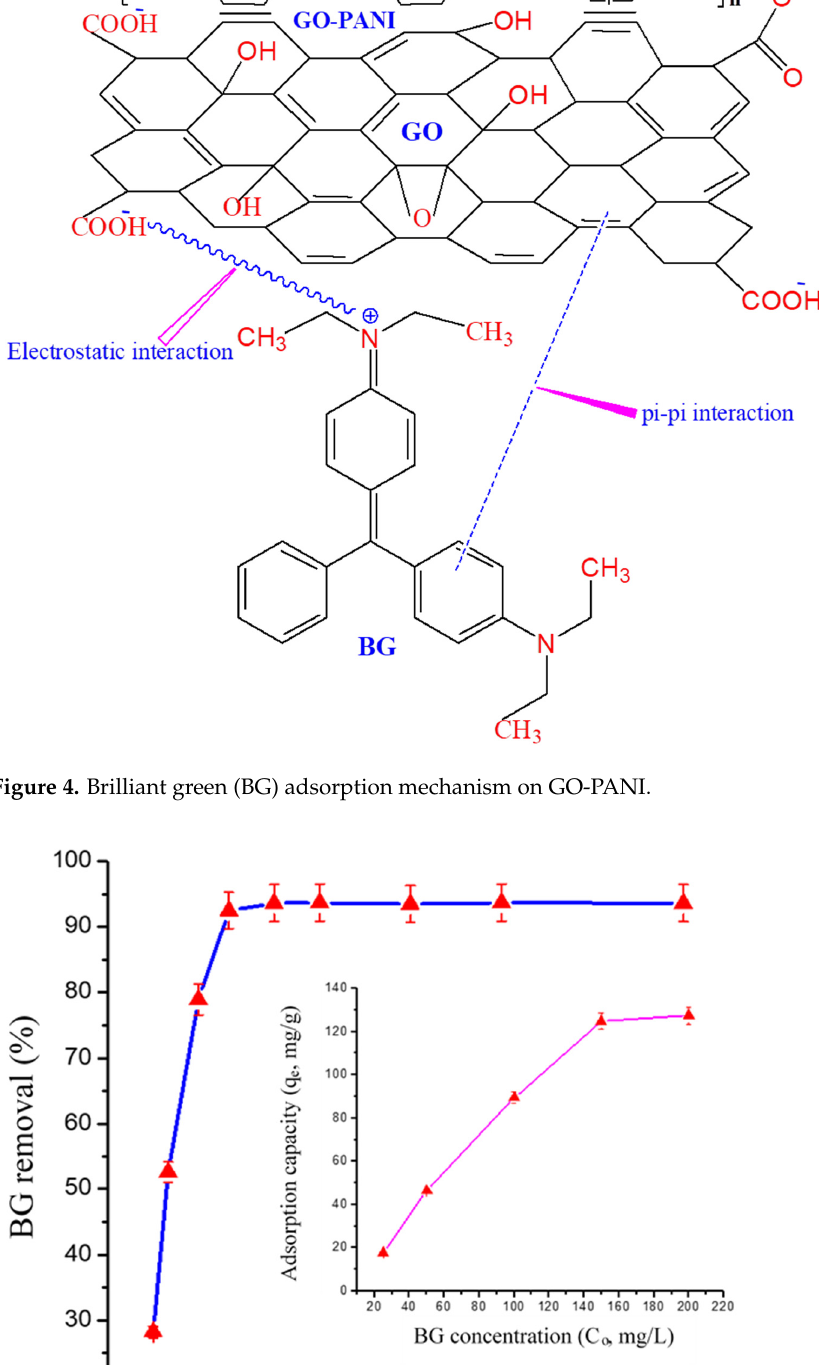
Figure 5. Effect of contact time on BG adsorption onto GO-PANI. Inset: Effect of concentration plot.